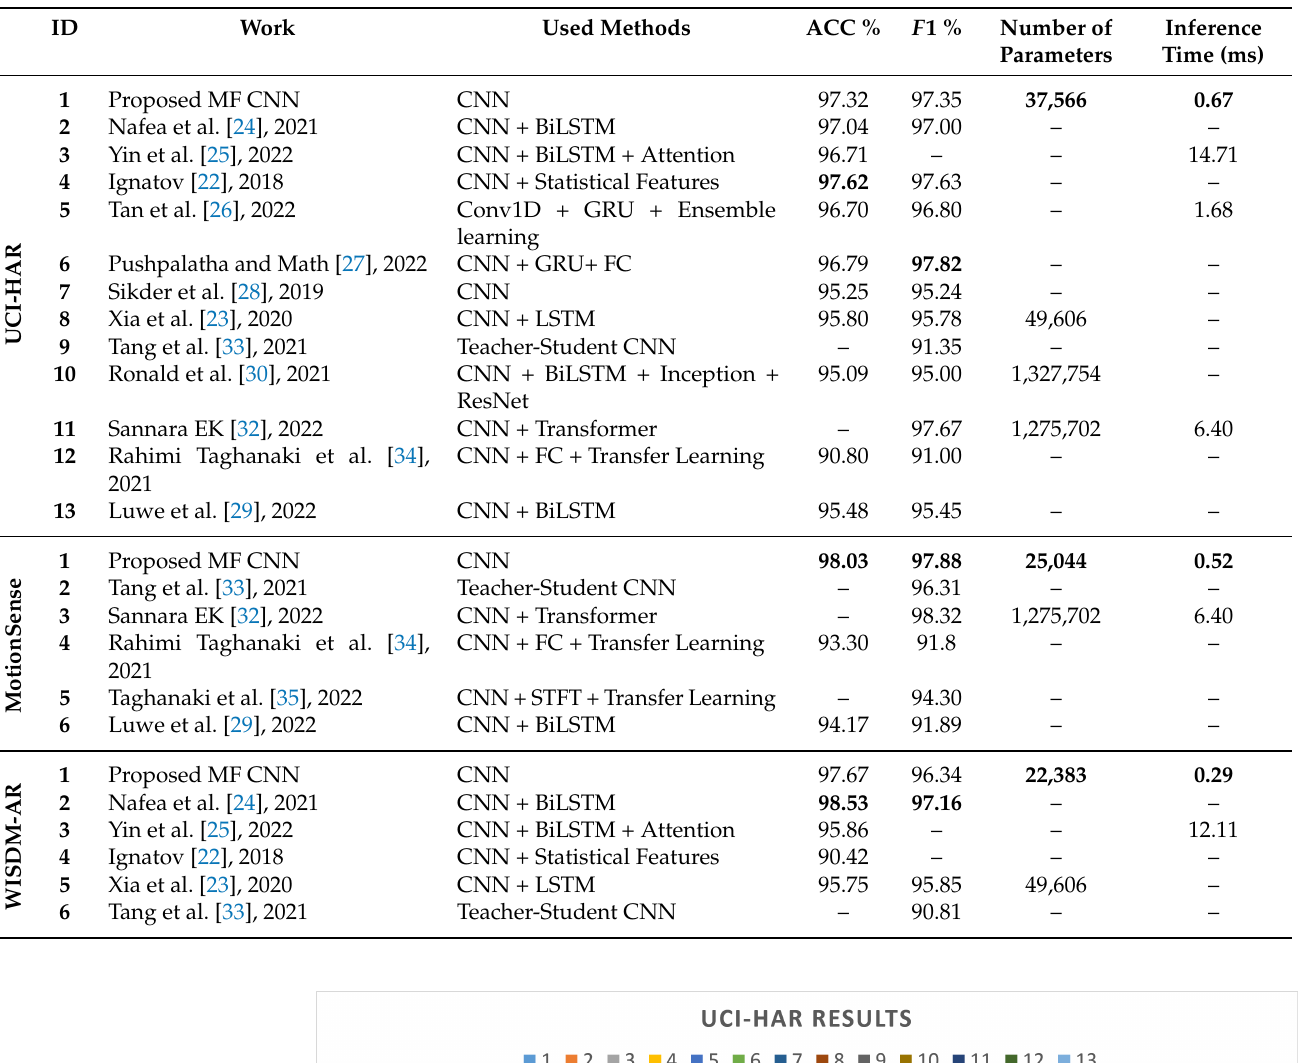
Table 4. Comparing the proposed model performance and benchmarking results with related works. Bold text indicates the best metric results per dataset.